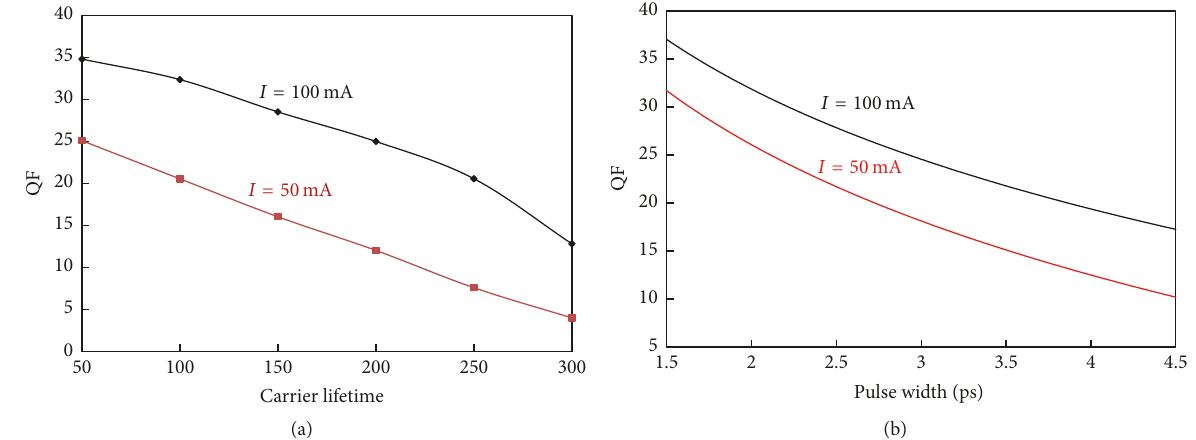
Figure 4: QF versus (a) SOA’s carrier lifetime and (b) pulse width for AND operation.